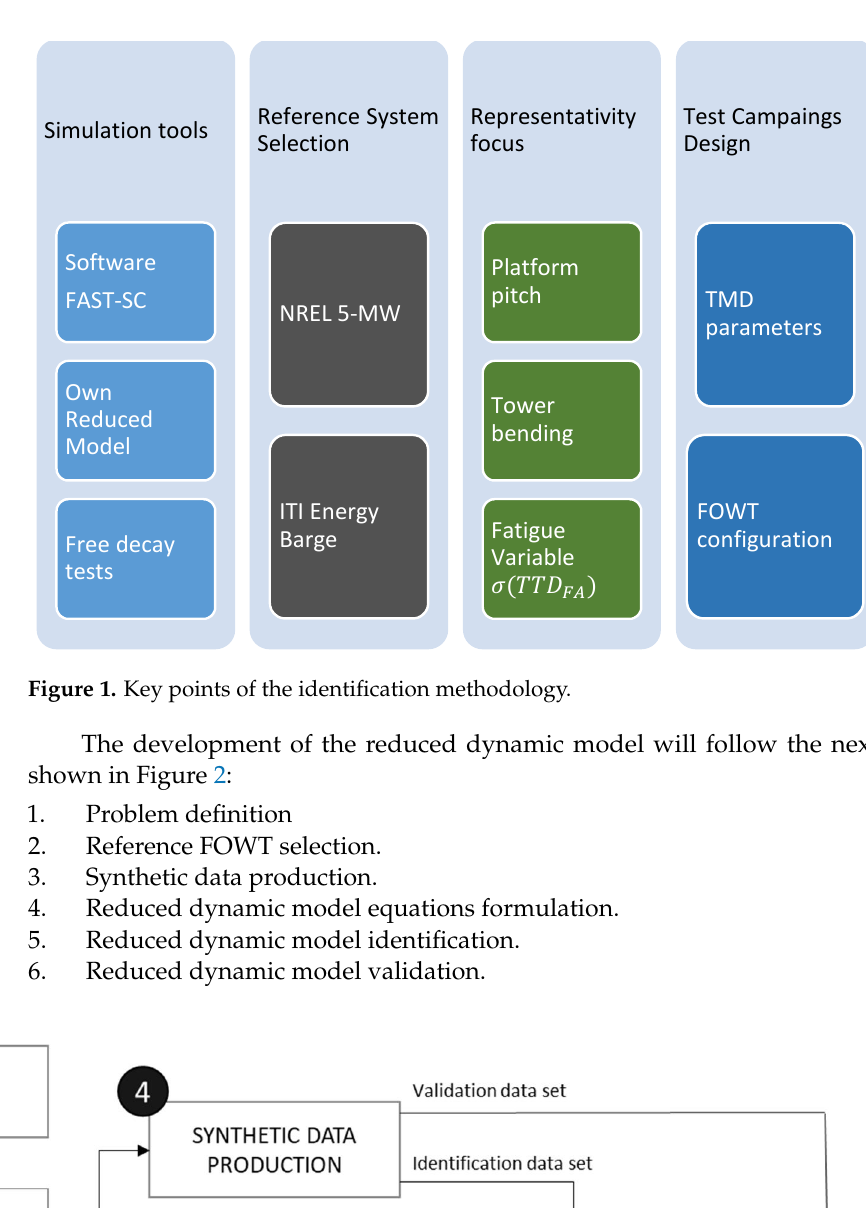
Figure 2. Identification methodology.